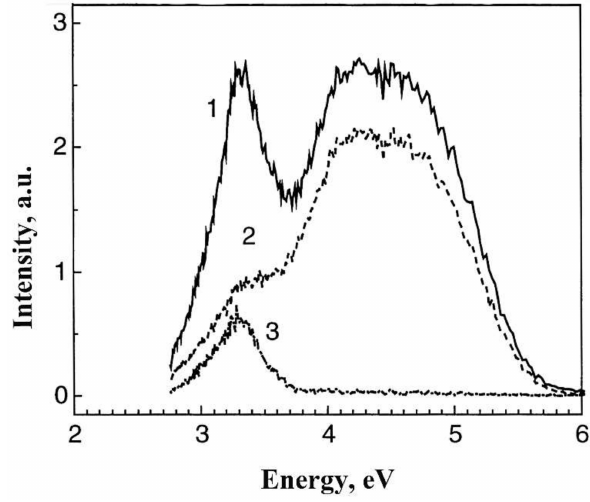
Figure 7. Emission spectra of Cs 2 LiLaCl 6 :Ce 3+ (1.0 mol%) under vacuum ultraviolet (VUV) excitation (19 eV) measured at 300 K. (1) Integral spectrum, (2) fast-emission component, and (3) slow emission component [41]. Copyright 2000,